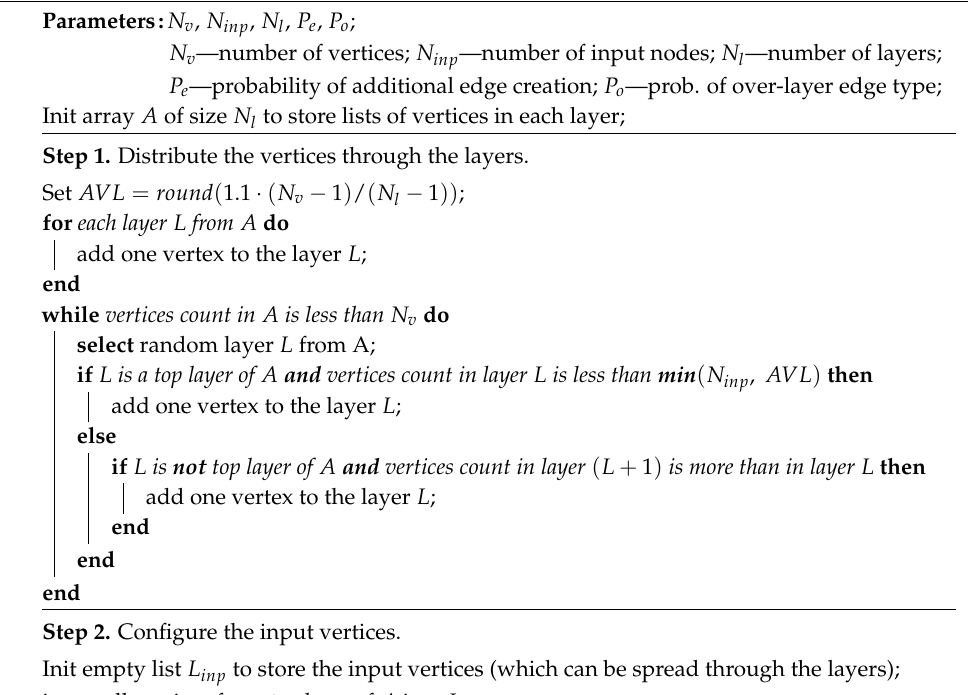
Algorithm 1: Generation of a rule-based directed graph of the